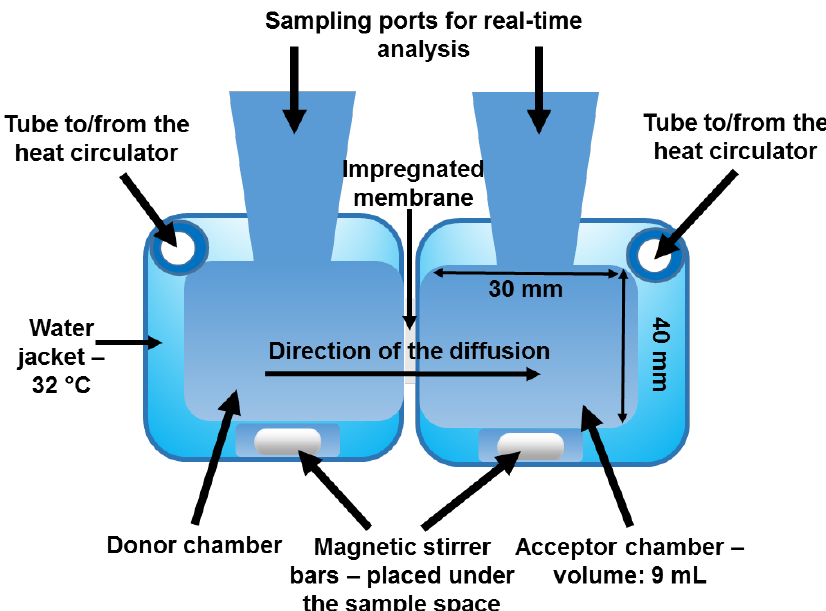
Figure 4. The setup of the modified horizontal device used for in vitro modeling of the penetration of nasal powders—the specified features of the different parts are described. of nasal powders—the specified features of the different parts are